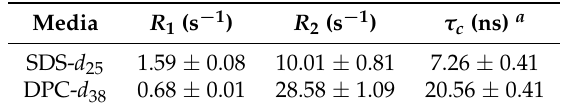
Table 1. 15 N R 1 and R 2 relaxation rates extracted from experimental data measured for the 15 N-labeled Ala261 at 303K on 18.8 T magnetic field.